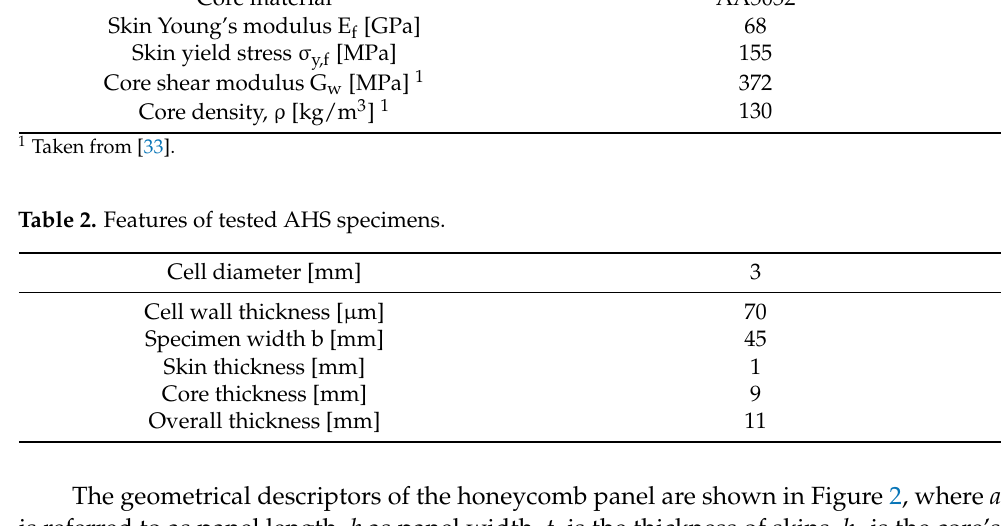
Figure 3. Experimental setup. Tests were performed under load control conditions at a load rate of 0.1 kN/s. To investigate the effect of the span, the tests were performed considering 130, 150, 170, 190, 210 and 220 mm spans. Two tests (defined as T1 and T2) were performed for each span to guarantee the repeatability of results. The pressure applied by the grips, which influences the boundary conditions, was set to 20 MPa. 2.2.2. Prediction Model The Smith [34] incremental–iterative approach was adapted to develop an analytical approach to estimate the stress–strain relationship and ultimate strength of the honeycomb panel, accounting for the critical stress based on the Johnson–Ostenfeld formulation [35] and the inelastic effects of the column’s buckling of the honeycomb panel, as defined in [33]. The descriptors of the employed formulations were calibrated to the experimental results in developing the load ‐ shortening relationship throughout Equations (1)–(10). The relationship describing the stress–strain relationship 𝜎 (cid:3398) 𝜀 or the elastic–plastic collapse of the honeycomb panel, valid for both positive (shortening) and negative (lengthening) strains, is defined as the column buckling failure mode below: